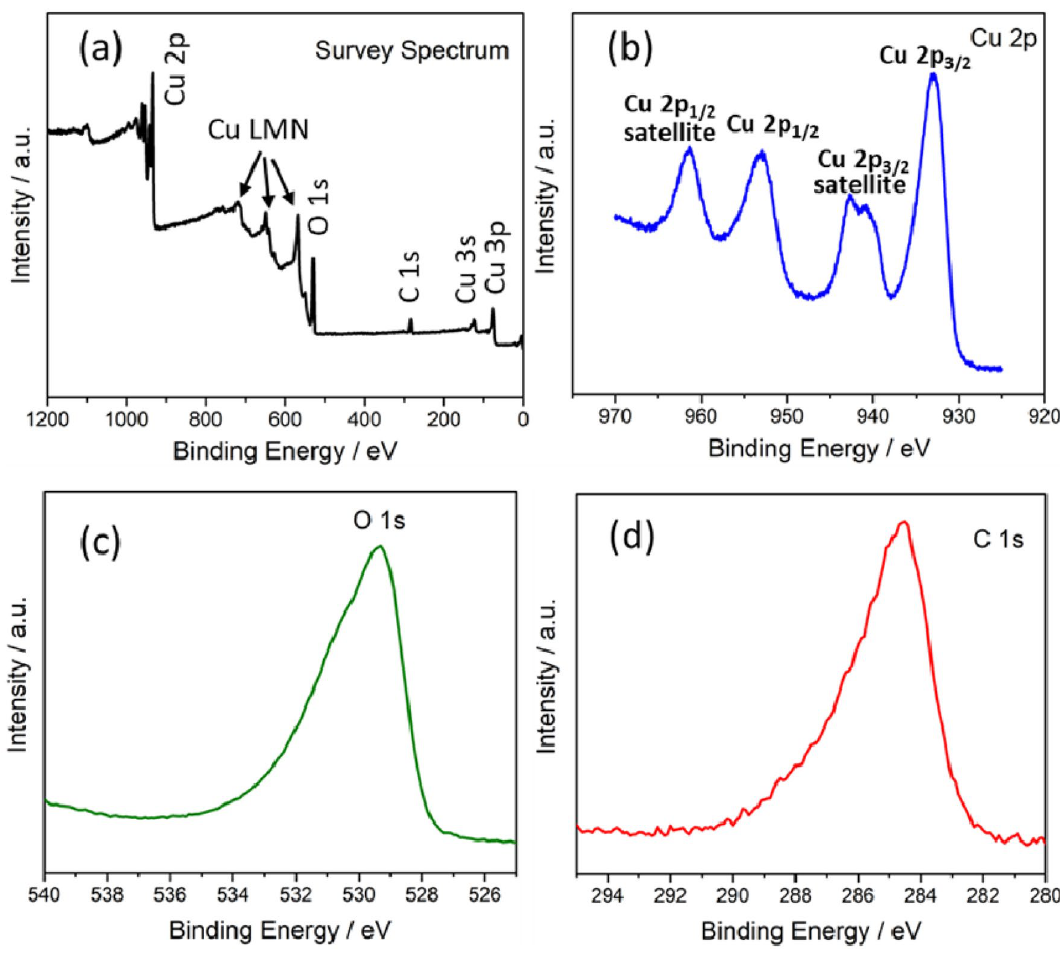
Figure 4. ( a – d ) XPS data of CuO nanoparticles: ( a ) Survey spectrum; ( b ) Cu 2p; ( c ) O 1 s and ( d ) C 1 s.